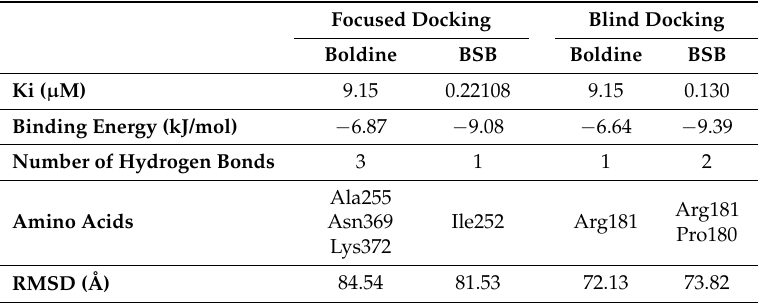
Table 1. Results of focused and blind docking of boldine and N -Benzylsecoboldine (BSB) with telomerase. (HB: hydrogen bonding; EB: energy of binding; Ki: Inhibitory constant). Focused